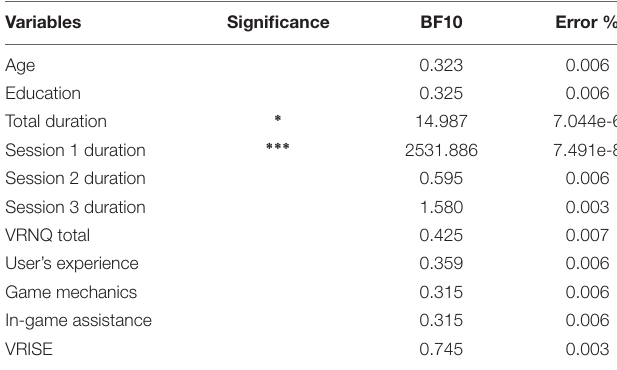
TABLE 5 | Bayesian independent samples t -test: gamers against